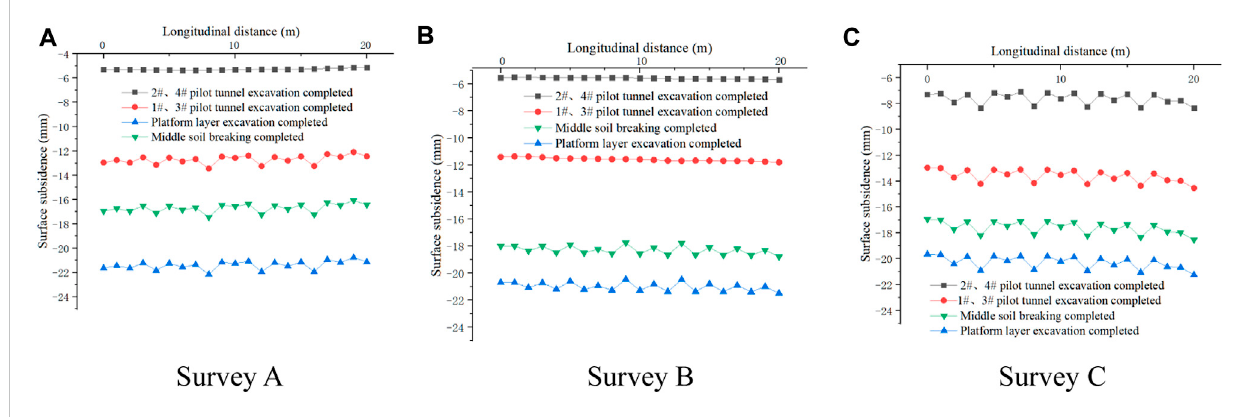
FIGURE 12 Longitudinal surface subsidence map of different parts.